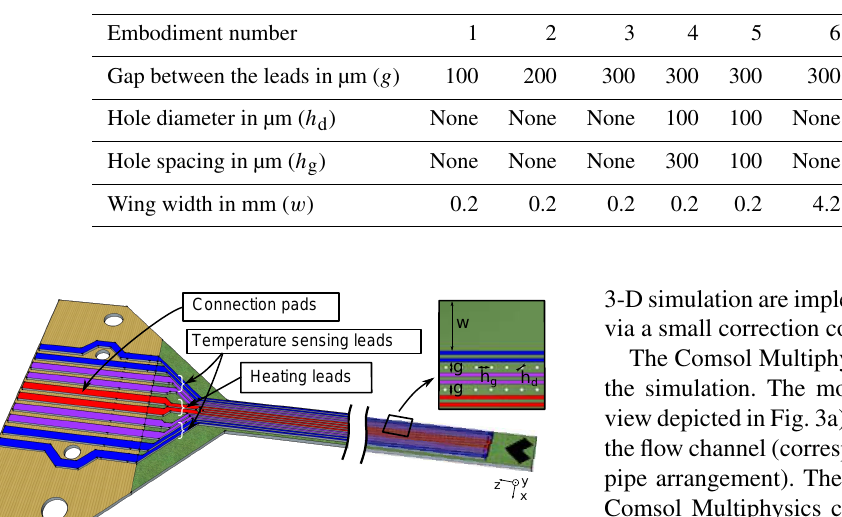
Table 1. Overview of the different sensor embodiments and the varied parameters.